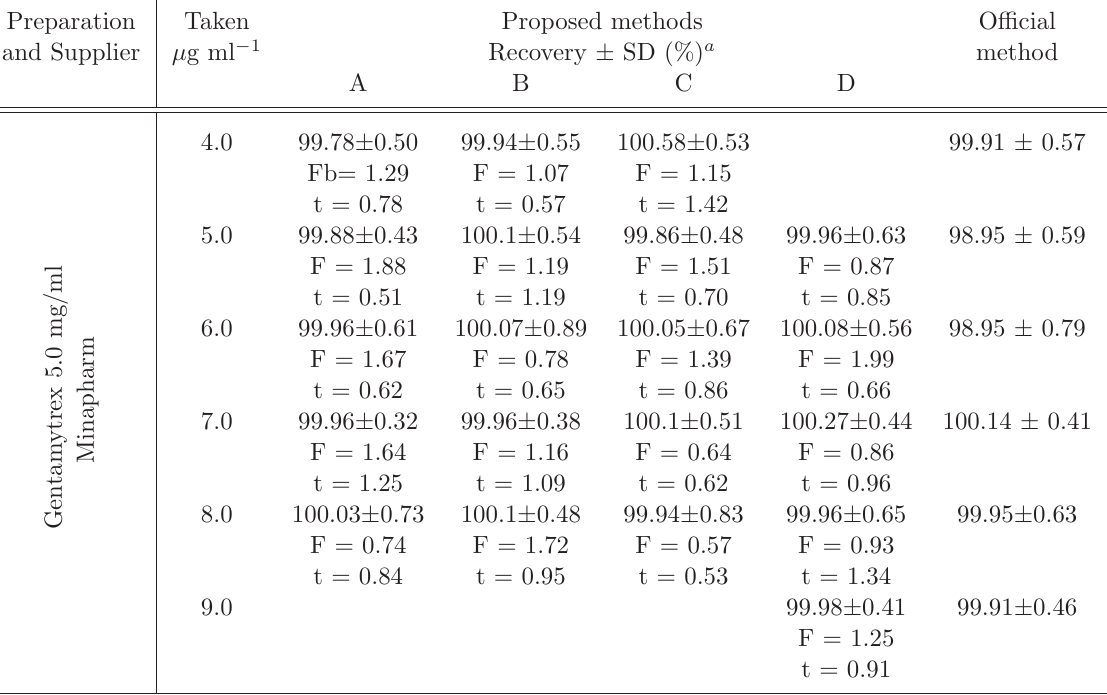
Table 6 Determination of gentamicin sulphate in gentamytrex pharmaceutical prepara- tion using the proposed